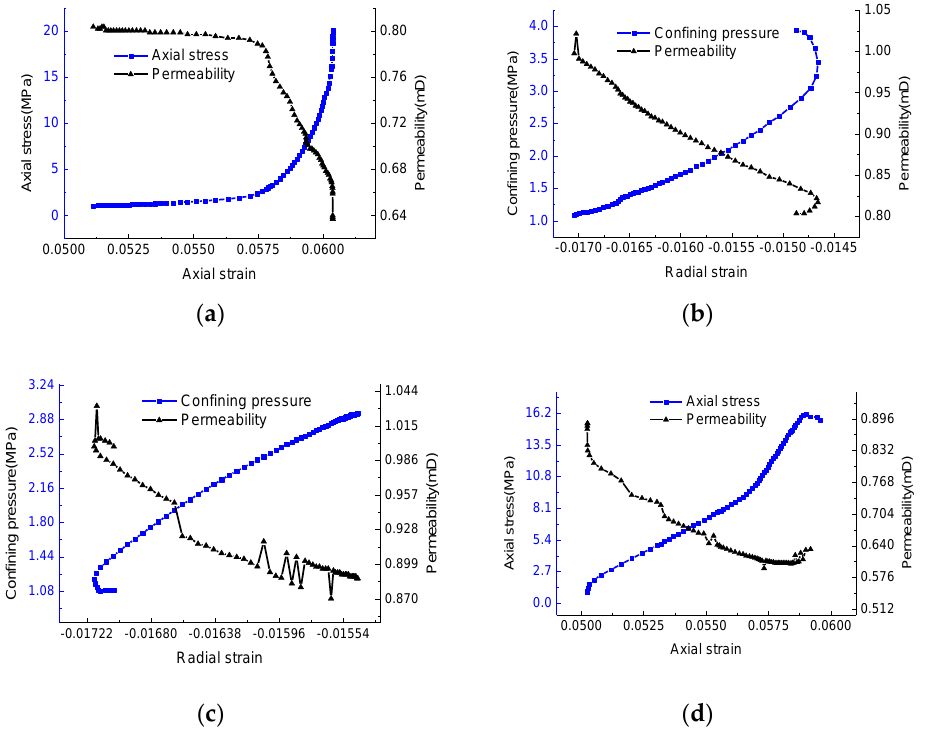
Figure 6. Experimental results of coal sample M3. ( a ) Unloading axial pressure; ( b ) unloading confining pressure; ( c ) loading confining pressure; ( d ) loading to secondary damage.